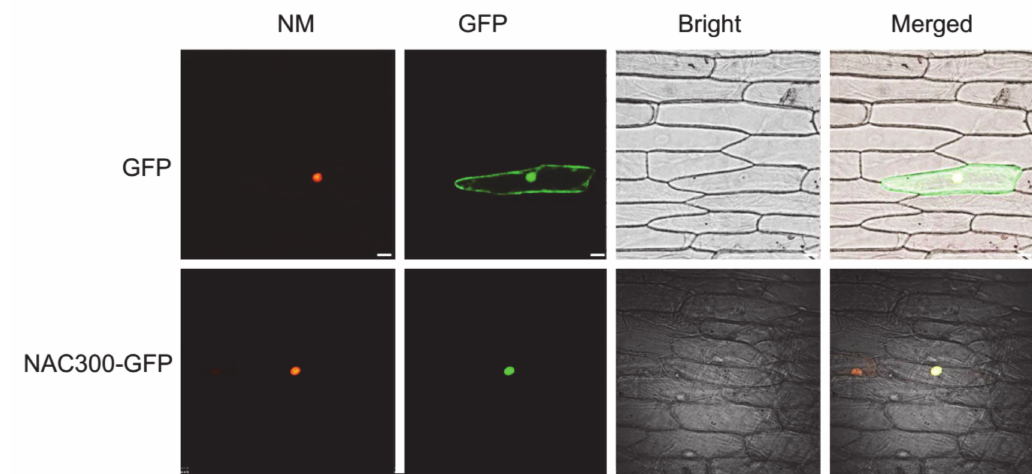
Figure 1. Subcellular localization of OsNAC300. Confocal images of onion epidermal cells expressing GFP , OsNAC300-GFP . RFP - H2A (red fluorescent protein Histone 2A); (nuclear marker, NM) is a nuclear localization tag. (Scale bars = 70 µ